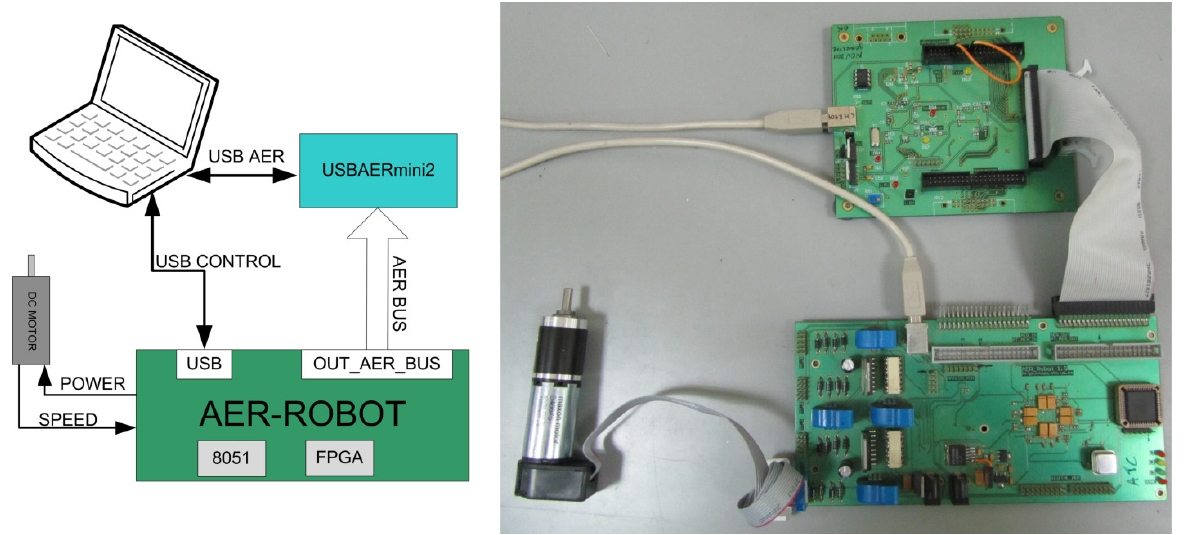
Figure 14. Experimental scenario: ( left ) block diagram; ( right )